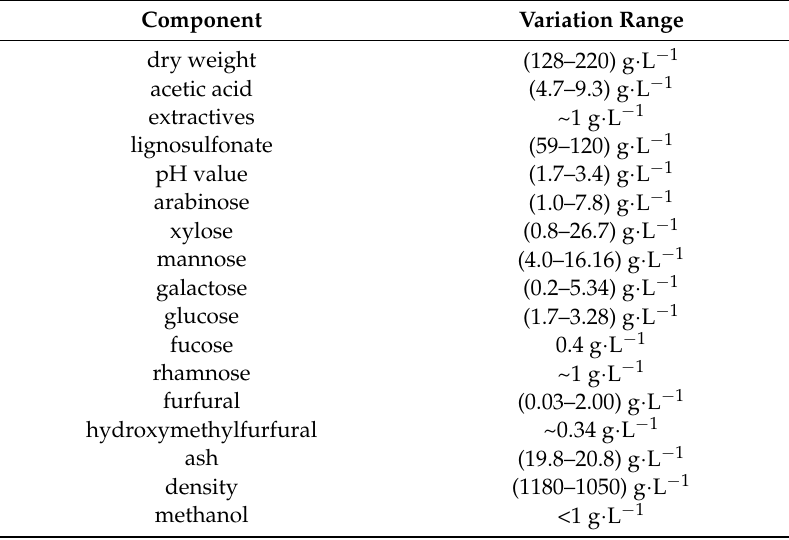
Table 2. Typical composition of spent sulfite liquors before evaporation